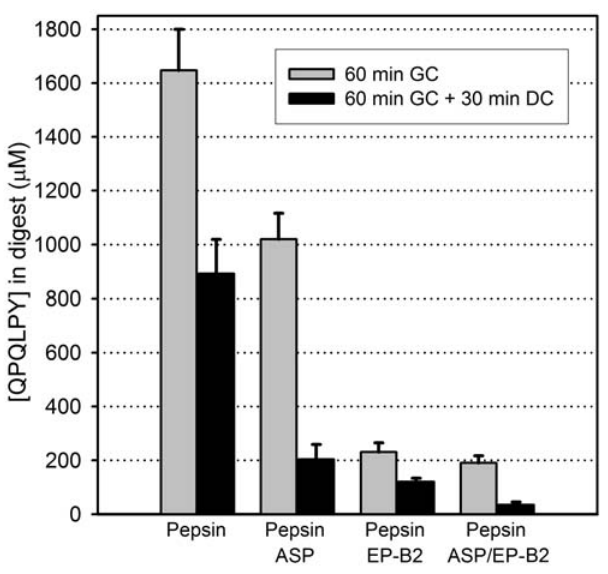
Figure 10. Detoxification of gluten by aspergillopepsin (ASP) and EP-B2 under conditions simulating digestion of a meal. Whole gluten powder (15 mg/ml) and casein (50 mg/ml) were digested with 0.6 mg/ml pepsin for 60 min at pH 4 (gastric conditions, GC), followed by treatment with 0.375 mg/ml trypsin and 0.375 mg/ml chymotrypsin for 30 min at pH 6.0 (duodenal conditions, DC). Where indicated, 0.35 mg/ml ASP, and/or 0.375 mg/ml proEP-B2 were added at the beginning of the gastric digestion phase. Gliadin peptides present in the digests were analyzed by competitive ELISA using the G12 monoclonal antibody, which is specific for the immunotoxic gliadin epitope QPQLPY.